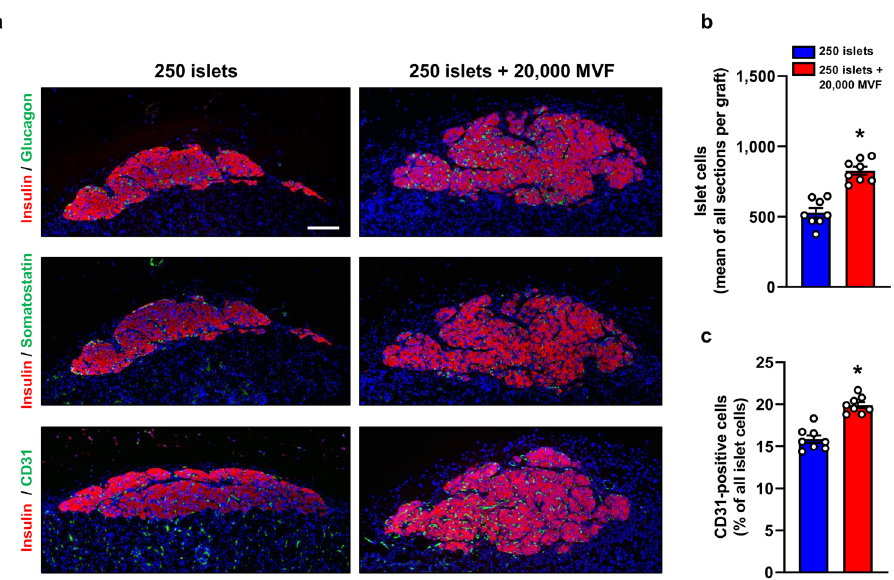
Fig. 3 Immunohistochemical analysis of the grafts under the kidney capsule. a Immuno fl uorescent stainings of insulin/glucagon, insulin/ somatostatin, and insulin/CD31 within the group of 250 islets alone and the group of 250 islets and 20,000 MVF on day 28 after transplantation. Scale bar: 100 µm. b Quantitative analysis of islet cells (mean of all sections per graft) within the group of 250 islets alone and the group of 250 islets and 20,000 MVF. Mean ± SEM ( n = 8 each group). An unpaired Student ’ s t test was used. * P < 0.05 vs. 250 islets. c Quantitative analysis of CD31-positive cells (% of all islet cells) within the group of 250 islets alone and the group of 250 islets and 20,000 MVF on day 28 after islet transplantation. Mean ± SEM ( n = 8 each group). An unpaired Student ’ s t test was used. * P < 0.05 vs . 250